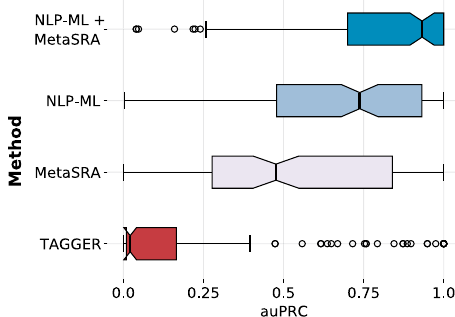
Fig. 2 | NLP-ML outperforms other text-based methods for sample tissue clas- si fi cation. Distribution of the area under the precision-recall curve (auPRC)scores across 153 tissues for each of the three individual text-based methods for sample classi fi cation: TAGGER, MetaSRA, and NLP-ML. Also shown is the distribution of auPRCscoresforcombiningthepredictionsofNLP-MLandMetaSRA.Eachpointin the boxplot is the performance for a single-tissue model averaged across cross- validation folds. In each boxplot (in a different color), the bounds of the box cor- respond to the distribution ’ s fi rst and third quartiles, the center line isthe median, the whiskers extend to the farthest data point within 1.5 times the interquartile range from the bounds, and the separate dots are outliers. Source data are pro- vided as a Source Data fi